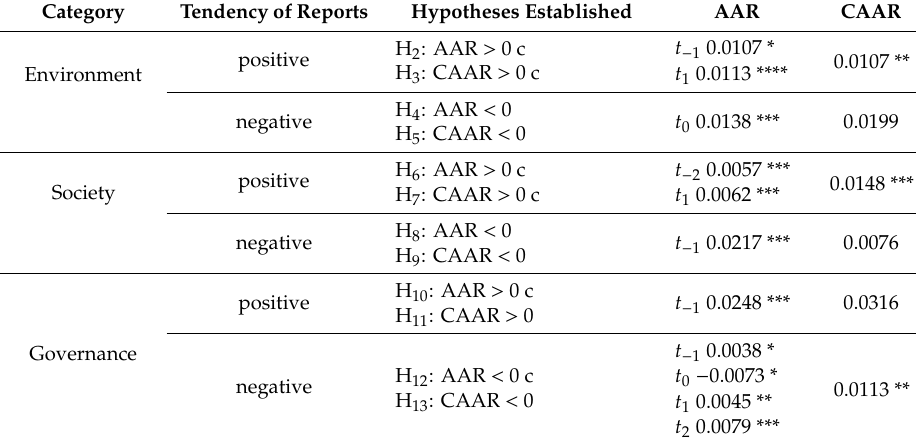
Table 9. Results of event